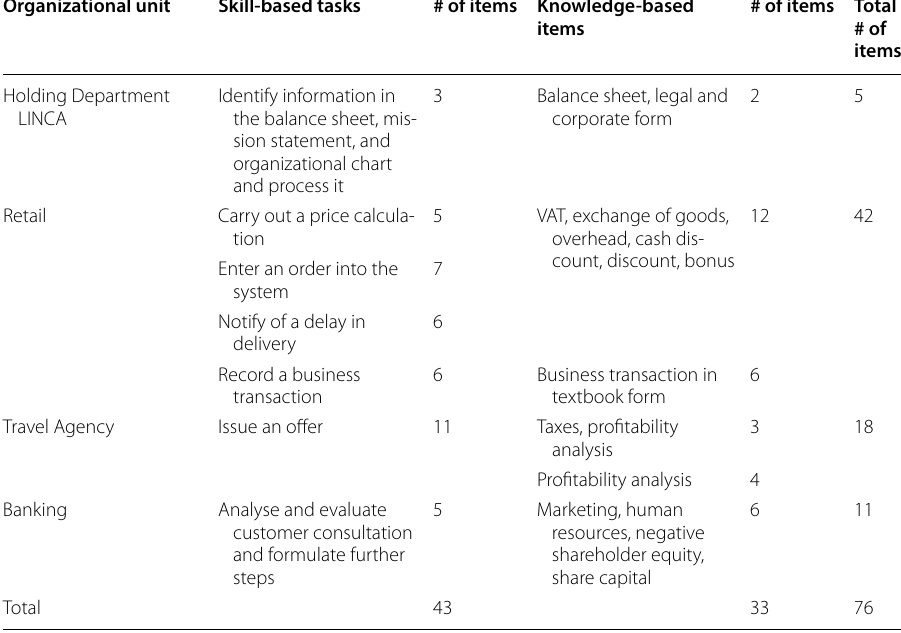
Table. 2 Tasks and items of simuLINCA Organizational unit Skill‑based tasks # of items Knowledge‑based